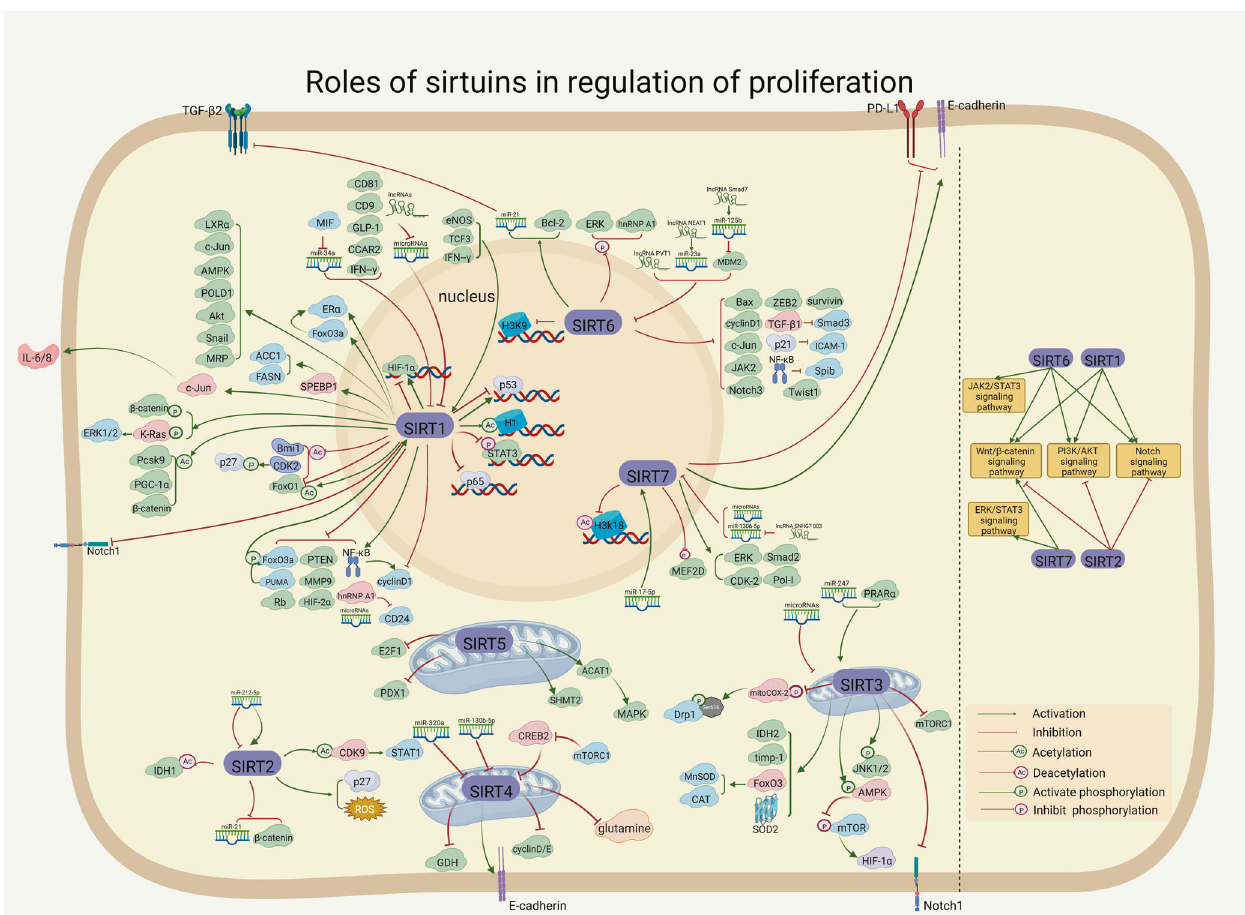
Fig. 7 Overview of the roles of SIRTs in cell proliferation. (i) SIRTs participate in regulating cell proliferation by affecting a group of downstream proteins, including p53, p65, STAT3, FOXO1, AMPK, etc. (ii) SIRTs are also regulated by a series of ncRNAs and proteins, such as lncRNA PVT1, miR-34a, IFN- γ , MDM2, PRAR α , eNOS, TCF3, etc, and subsequently promote or inhibit cell proliferation directly. (iii) In addition, SIRTs could activate or inhibit several signaling pathways, which perform important roles in cell proliferation, including JAK2/STAT3 signaling pathway, Wnt/ β -catenin signaling pathway, PI3K/AKT signaling pathway, Notch signaling pathway, and ERK/STAT3 signaling pathway. Activation and inhibition effects are displayed in green and red arrows, respectively. https://biorender.com. ACAT1 acetyl coenzyme A acyltransferase1, Bmi-1 B-cell-speci fi c Moloney murine leukemia virus integrationsite-1, CCAR2 cell cycle and apoptosis regulator protein 2, CDK9 cyclin-dependent kinase9, Drp1 dynamin-related protein 1, Er α estrogen receptor α , FASN fatty acid synthase, GLP-1 glucagon-like peptide-1, H1 histone1, HIF-2 α hypoxia inducible factor-2 α , K-Ras p21, MEF2D myocyte enhancer factor 2D, mitoCOX-2 mitochondria cyclooxygenase-2, MRP migration inhibitory-factor related protein, mTORC1 mTOR complex 1, Pcsk9 proprotein convertase subtilisin/kexin type 9, PD-L1 programmed death 1-ligand 1, POLD1 DNA polymerase delta 1, Pol-I DNA polymerase I, BBC3 Bcl-2 binding component 3, Rb retinoblastoma protein, SPEBP1 phosphatidylethanolamine binding protein 1, STAT1 signal transducer and activator of transcription 1, TCF3 transcription factor 3, Twist1 twist family bHLH transcription factor 1, ZEB2 zinc fi nger E-box binding homeobox